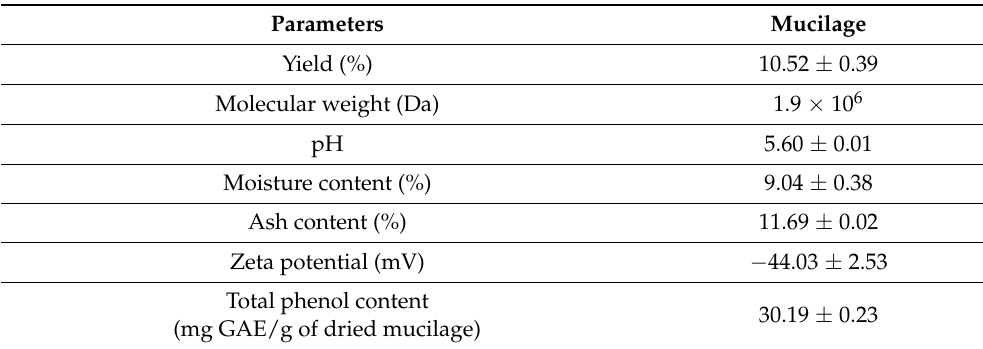
Table 1. Results of yield, pH, and chemical composition of the mucilage extracted from the Corchorus olitorius